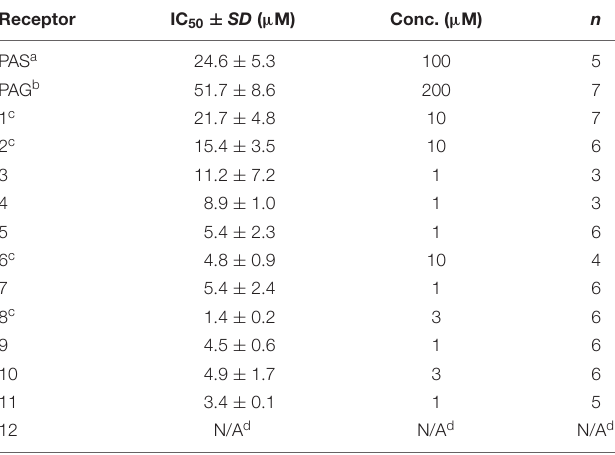
amphipathic character of compounds 1–12 is similar to our previously published D -modified steroids (Kudova et al., 2015), we have used an identical approach for the assessment of the obtained data and calculation of the IC 50 values. In brief, the IC 50 for the newly synthesized steroids was determined from a